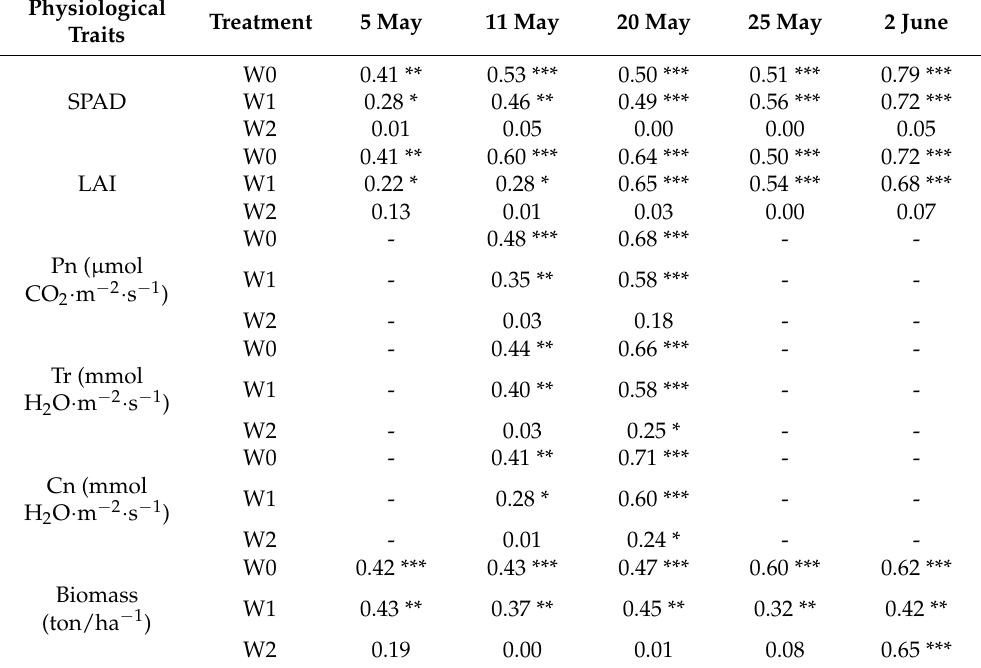
Table 5. The linear relationship between CT-UAV and physiological traits in different deficit irriga- tion treatments. Physiological Traits